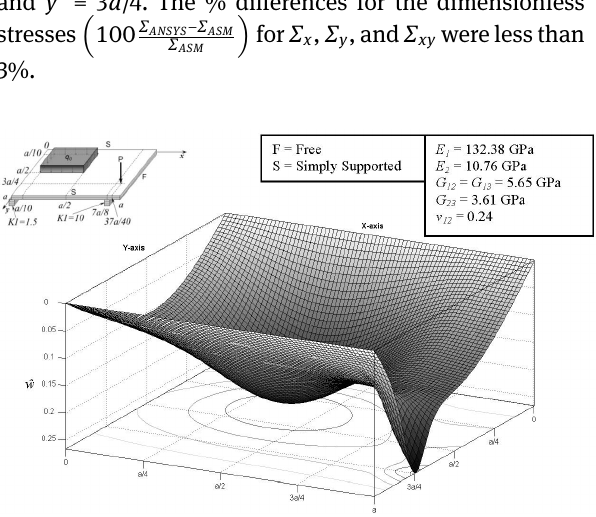
Figure 8: Contour of the dimensionless deflection for an antisym- metric angle-ply 6-layer (-15/-45/-75/75/45/15) square laminated plate simply supported at y = 0 and y = a , beam supported at x = 0 and at x = 7 a /8 , and subjected to a patch load and a concentrated load (Note: the isotropic beams are concentric and only half of the beams on bottom side of the plate are shown for